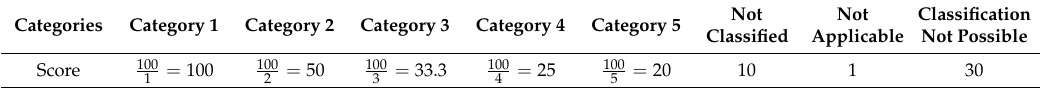
Table 2. Results of quantification of health hazard